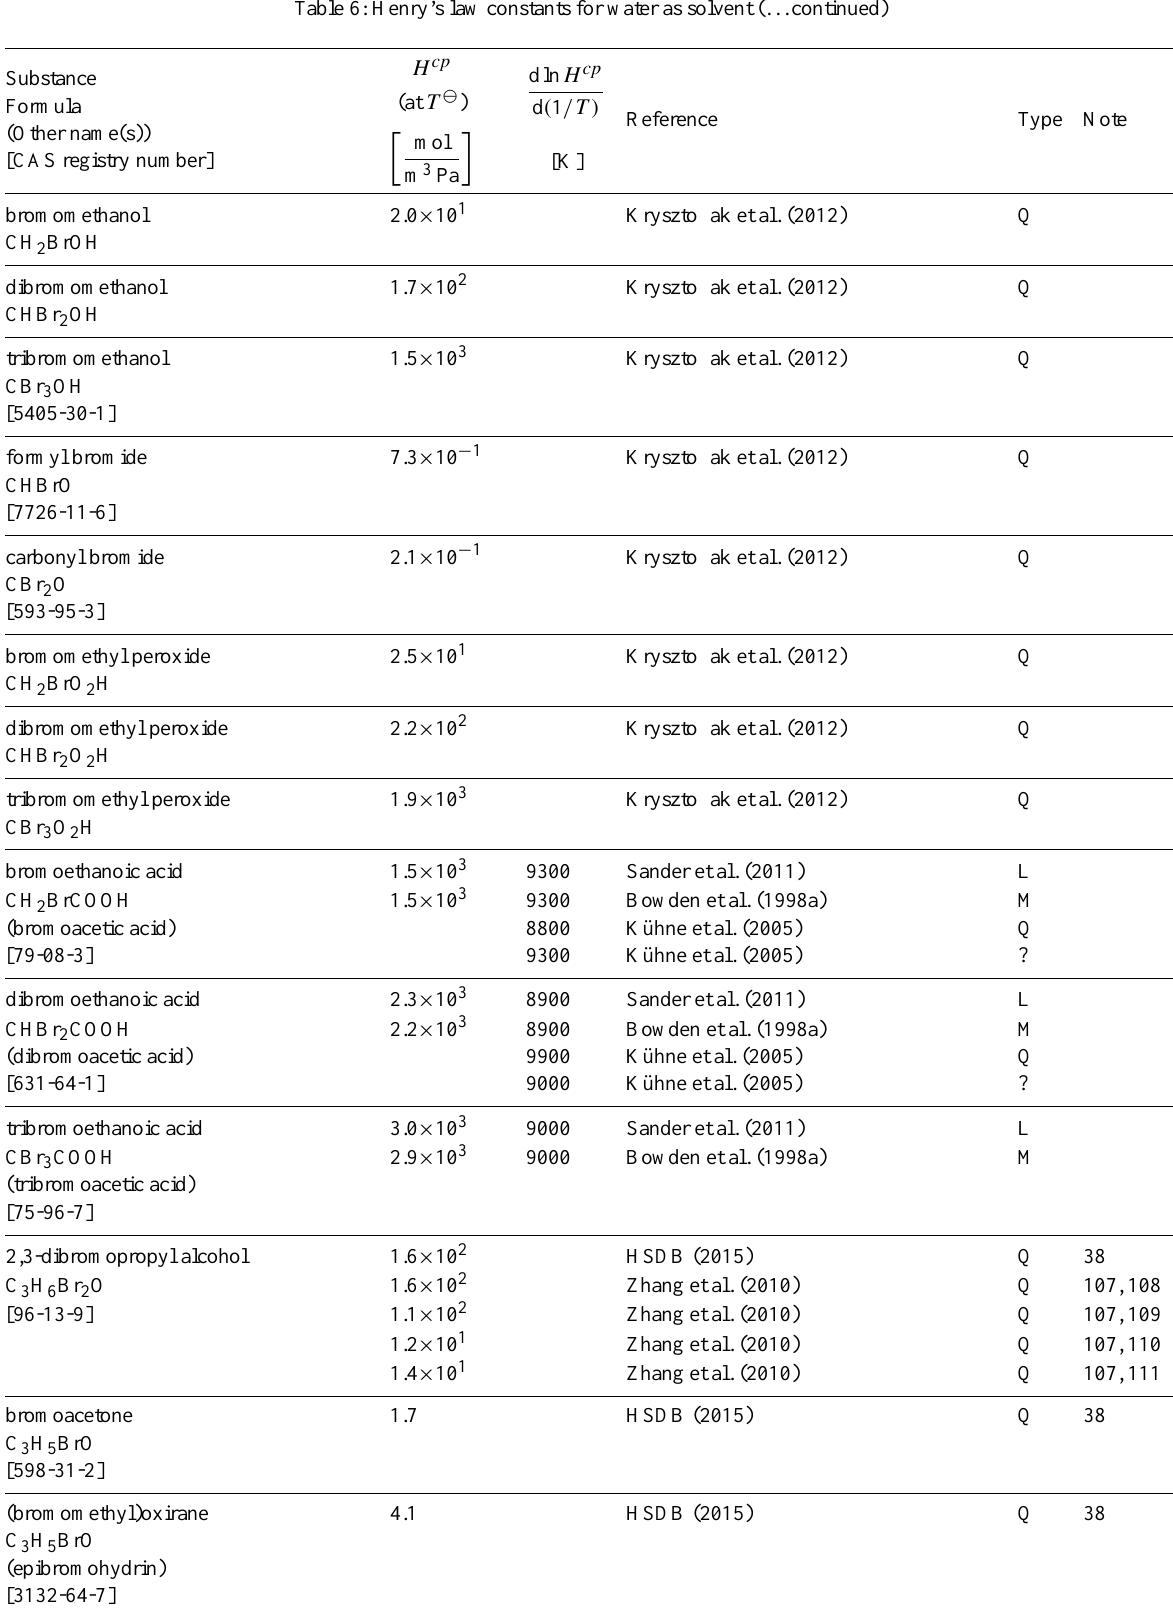
Table 6: Henry’s law constants for water as solvent